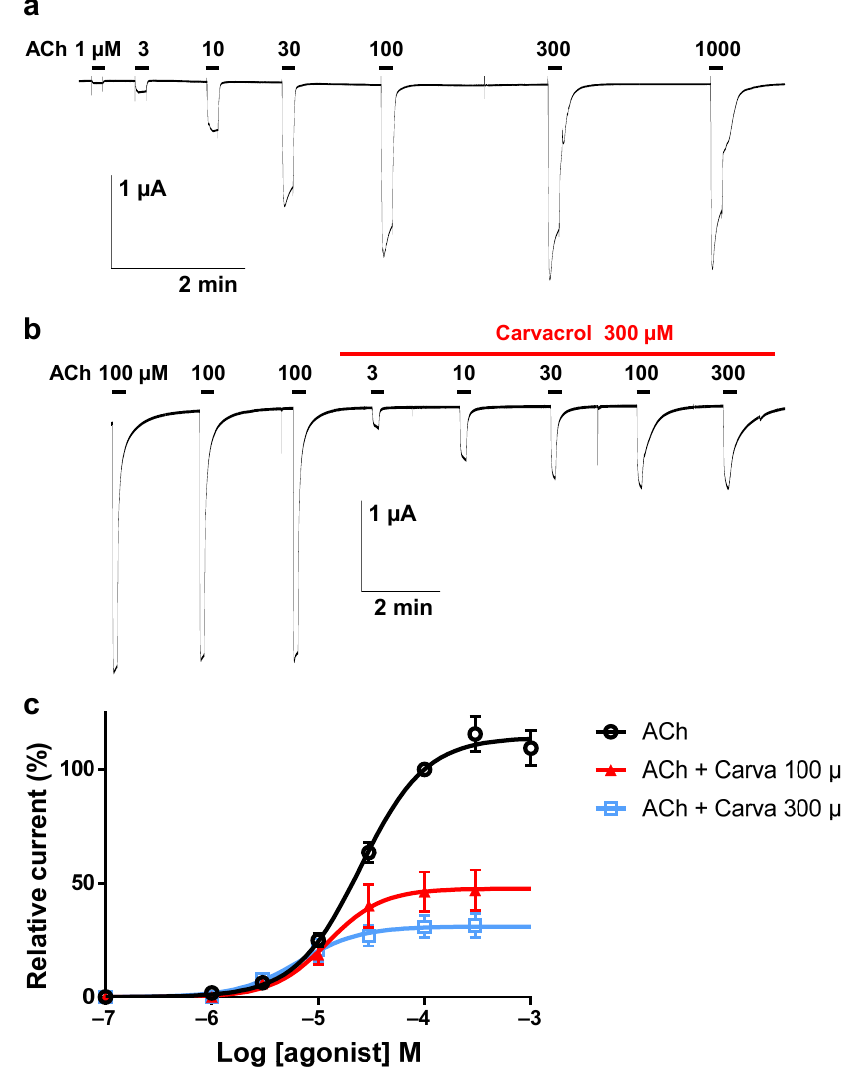
Figure 3. Concentration–response relationships of ACh on the Parascaris sp. ACR-26/27 M-AChR expressed in Xenopus laevis oocytes in absence of carvacrol ( a ) or in presence of carvacrol ( b ). Representative current traces for single oocytes. The concentrations of ACh and carvacrol ( µ M) are indicated above each trace. Bars indicate drug applications: ACh was applied for 10 s. ( c ) Concentration–response curves. All responses are normalized to 100 µM ACh. Results are shown as the mean ± SE ( n = 5 – 6).